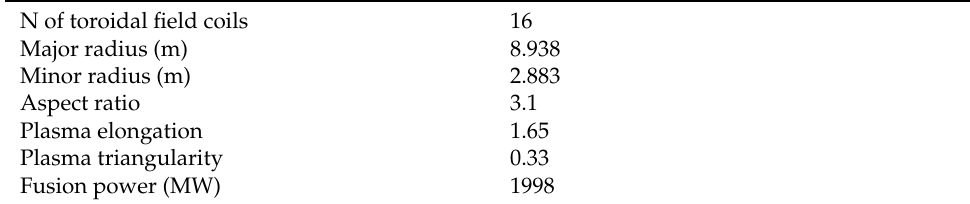
Figure 4. EU DEMO MCNP model with Helium-Cooled Pebble Bed (HCPB) ( Left ) and Water-Cooled Lithium Lead (WCLL) ( Right ) layered blanket concept. Table 1. Main parameters of the DEMO1 baseline configuration [16].